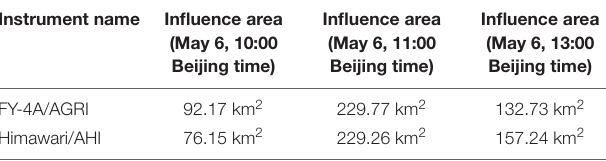
TABLE 5 | Area of Taihu Lake affected by floating algae, as estimated from FY-4A/AGRI and Himawari/AHI data.